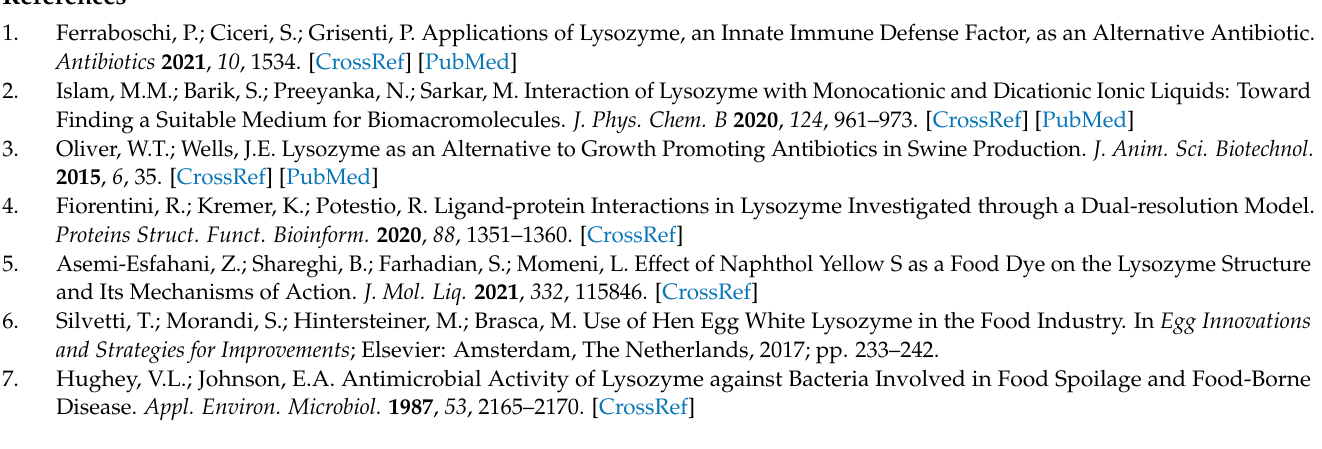
all frames of each trajectory. Figure S3: (A) Ramachandran plot of energy minima structure of free lysozyme alone. (B) Ramachandran plot of energy minima structure of lysozyme-substrate complex. (C) Ramachandran plot of energy minima structure of lysozyme-doxofylline complex. Table S1: Total binding energies (Etotal is total energy) (kcal mol − 1 ) of major energy contributors for the interaction of substrate and doxofylline with lysozyme calculated from